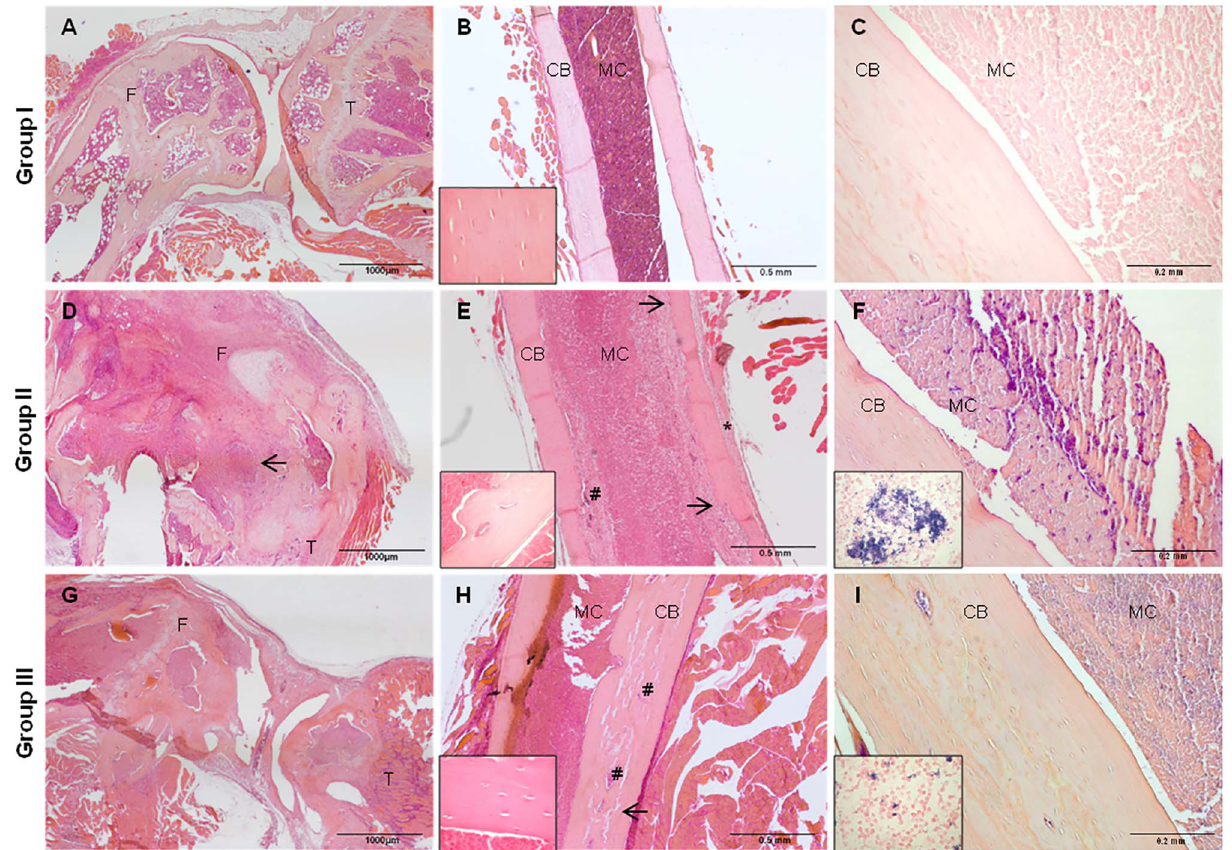
Fig. 3. Histology of the femurs in the experimental groups (n=4). Figures represent H&E staining in the left and middle panels and Gram- positive staining in the right panel. Legend: femur (F), tibia (T), cortical bone (CB), and medullary canal (MC). Group I - A) Normal aspect of the knee joint and absence of signs of infection (Magnification 2X, scale bar 1 mm); B) Absence of inflammatory cells in the medullary canal, of bone resorption or periosteal reaction (Magnification 4X, scale bar 0.5 mm) and presence of osteocytes within cortical bone lacunae (small box, Magnification 1000X); C) Absence of Gram-positive bacteria aggregates (Magnification 10X, scale bar 0.2 mm). Group II – D) Abscesses in the knee joint (black arrow) and in the medullary canal (Magnification 2X, scale bar 1 mm); E) Endosteal bone resorption ( # ), active osteoclasts (black arrows), marked periosteal reaction (*) (Magnification 4X, scale bar 0.5 mm) and diffuse enlargement of the medullary canal with osteoclastic resorption in the endosteal side (small box, Magnification 20X, scale bar 0.1 mm); F) Presence of numerous Gram-positive bacteria aggregates (Magnification 10X, scale bar 0.2 mm; small box, Magnification 1000X). Group III - G) Irregular surface of the articular cartilage of the knee joint and mild inflammatory changes of bone and joint (Magnification 2X, scale bar 1 mm); H) Diffuse increase of the vascular network and bone vessel enlargement ( # ) and areas of bone remodeling (black arrow) (Magnification 4X, scale bar 0.5 mm); large osteocytes embedded in cortical bone lacunae (small box, Magnification 1000X); I) Mild presence of dispersed Gram-positive bacteria within the medullary canal (Magnification 10X, scale bar 0.1 mm; small box, Magnification 1000X).